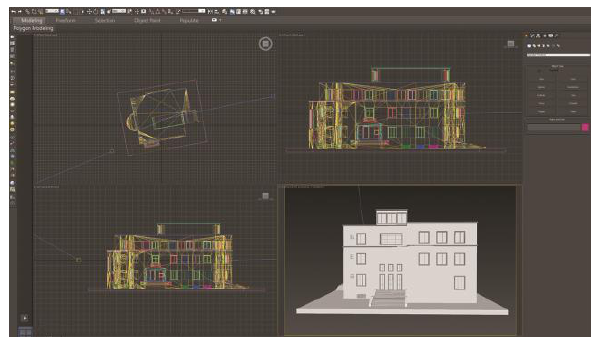
Figure 3. The Royal Park of Tirana. 3D model of the Villa Reale created by the digital platform.